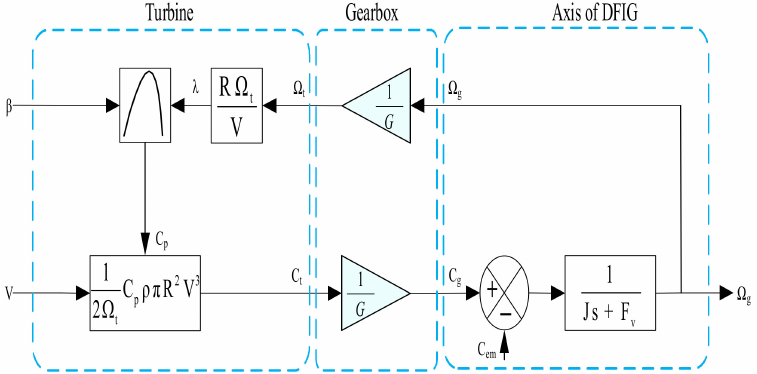
Figure 3. Aerodynamic model of the wind